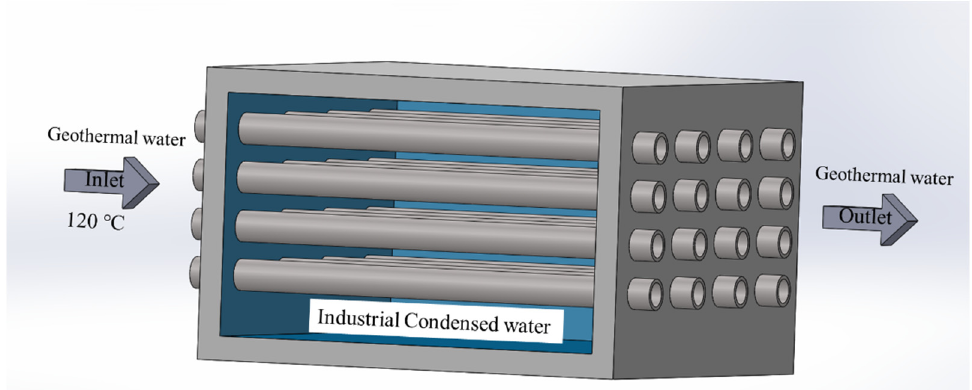
Figure 1. Schematical diagram of the service condition of the convection tube.